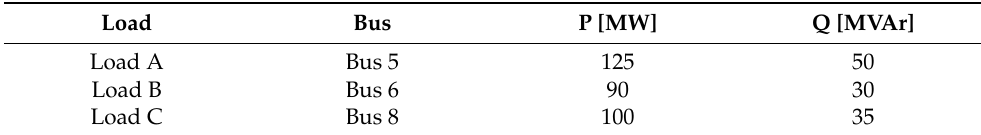
Table 1. Load distribution in IEEE nine-bus test system.